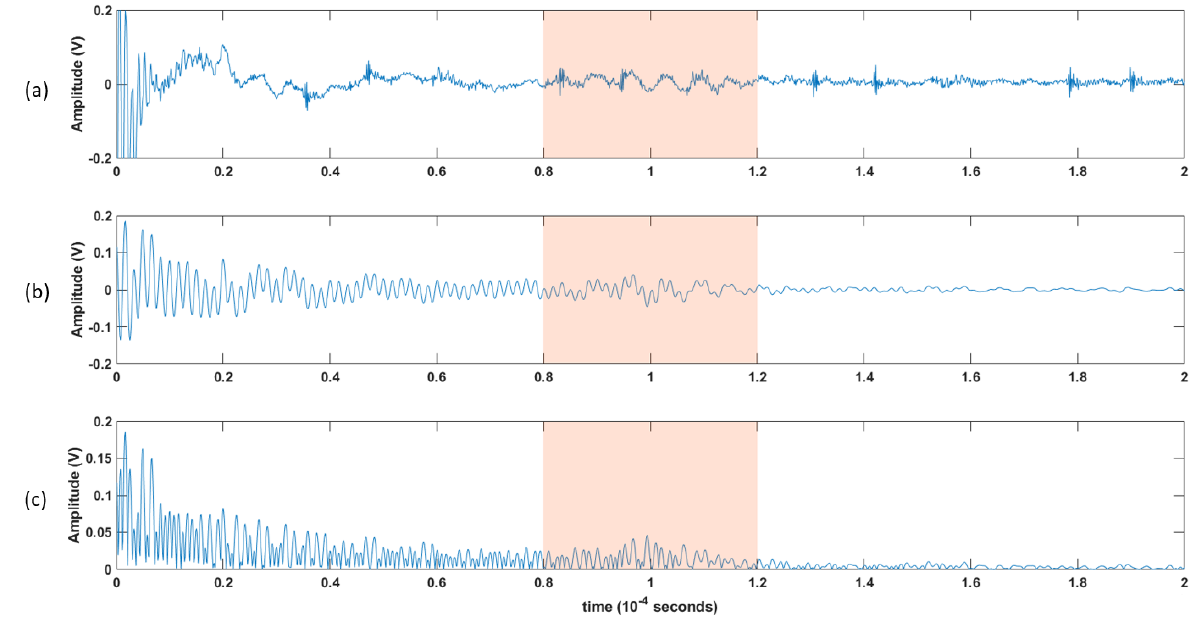
Figure 6. An illustration of the processing steps: ( a ) 200 μs window for the raw collected data. ( b ) the 200 μs collected data after being filtered using a bandpass filter, and then ( c ) rectified. A 40 μs window of interest is shown in the shaded area, and further processing will be applied.